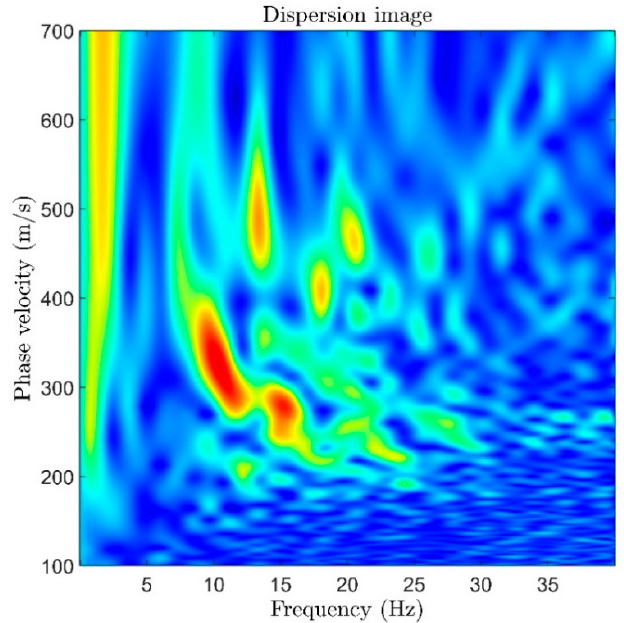
aging. after averaging.